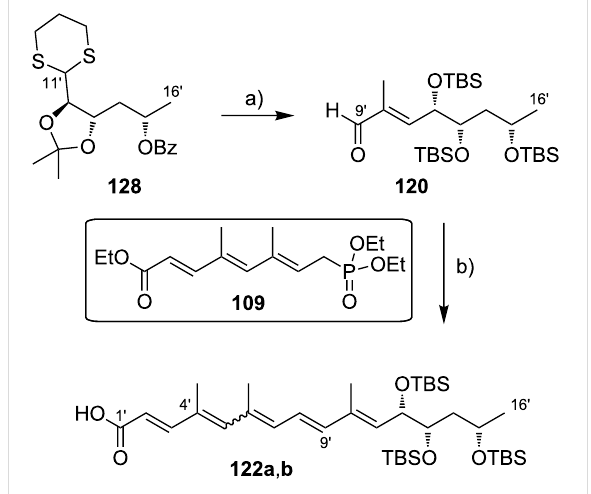
Scheme 17: Altmann’s approach towards the mycolactone A/B pentaenoate side chain. Reagents and conditions: a) (i) NaH, MeOH, rt, 95%; (ii) cat. TFA, AcOH, H 2 O, rt, quant.; (iii) TBSCl, imidazole, DMF, 70 °C, 96%; (iv) MeI, 2,4,6-collidine, acetone, H 2 O, reflux,